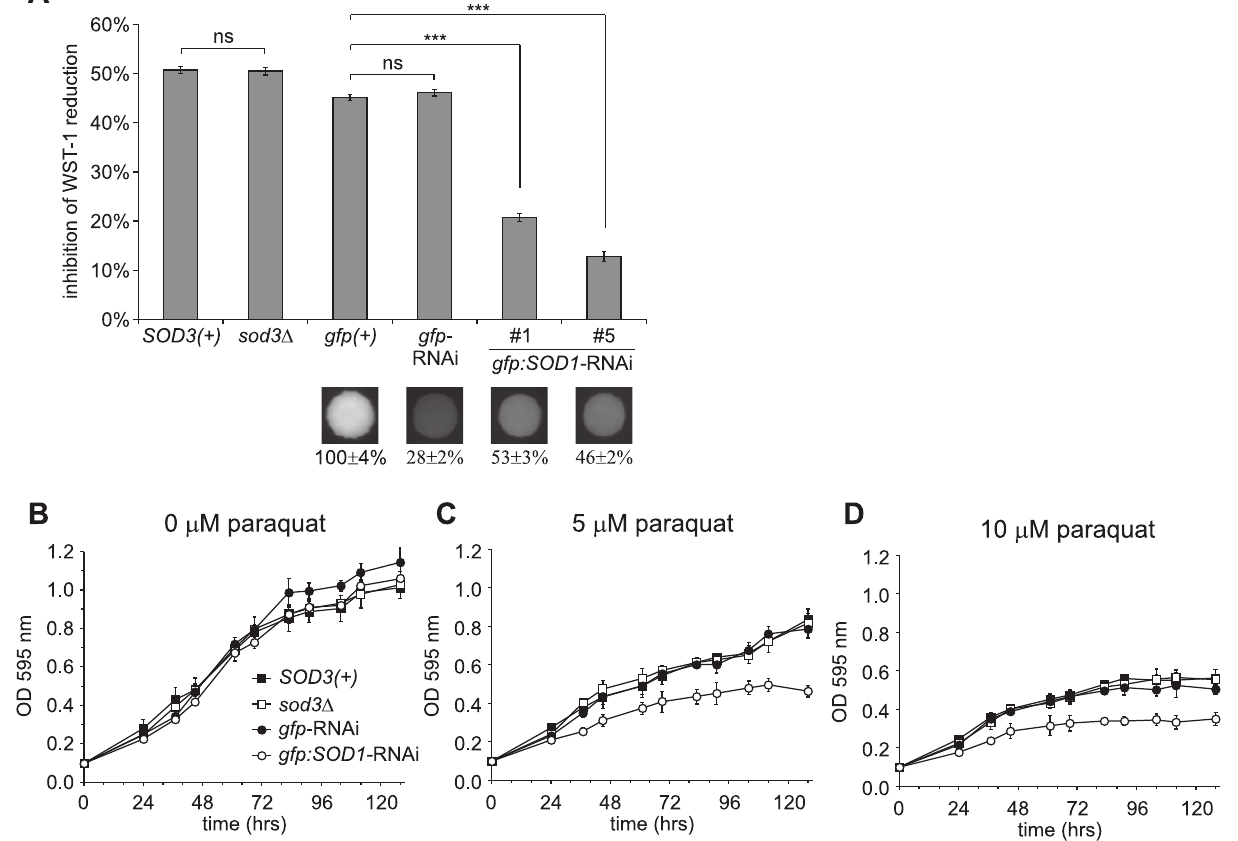
Figure 3. Histoplasma Sod3 does not alleviate intracellular oxidative stress. ( A ) Depletion of intracellular superoxide dismutase activity by SOD1-RNAi but not by loss of Sod3. RNAi-based depletion of Sod1 was done in a GFP-expressing Histoplasma strain (OSU22). GFP fluorescence is shown in colony images of a strain in which gfp was not targeted ( gfp( + ) ; OSU103), gfp alone was targeted ( gfp-RNAi ; OSU104) or two independent isolates in which gfp and SOD1 were co-targeted ( gfp:SOD1-RNAi ; OSU105). Numbers below the images indicate relative GFP fluorescence. Intracellular superoxide dismutase activity was determined by inhibition of WST-1 reduction using 5 m g of cellular lysate protein from SOD3( + ) (OSU45), sod3 D (OSU15), and the RNAi strains and results plotted relative to uninhibited reactions using 5 m g BSA. Non-significant (ns) and significant (*** p , 0.001) differences between SOD3( + ) and sod3 D or between the SOD1( + ) strain ( gfp( + ) ) and the gfp -RNAi or SOD1 -RNAi strain are indicated above the columns. ( B–D ) Inhibition of yeast growth by increased intracellular reactive oxygen. Liquid growth of SOD3( + ) (OSU45), sod3 D (OSU15), Sod1-proficient ( gfp-RNAi ; OSU104), and SOD1-RNAi ( gfp:SOD1-RNAi ; OSU105) strains was determined by optical density of cultures measured at 595 nm. Intracellular reactive oxygen was increased in yeasts by addition of 5 m M ( C ) or 10 m M ( D ) paraquat. Growth curve points represent the mean optical density of replicate cultures (n=3).